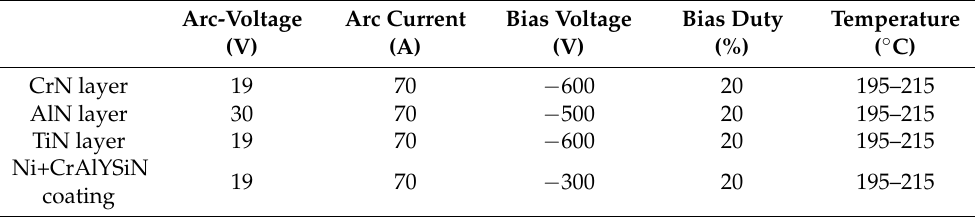
Table 1. Typical deposition